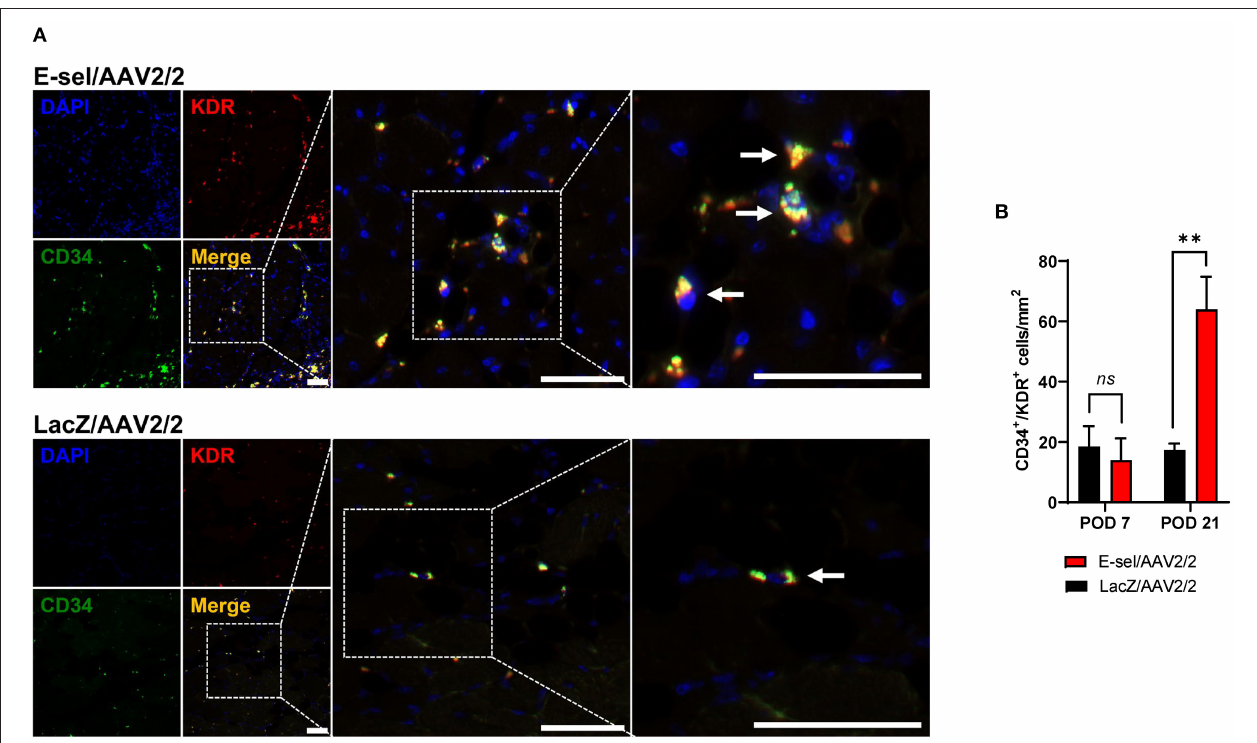
FIGURE 3 | Recruitment of endothelial progenitor cells (EPCs) to ischemic muscle is enhanced by E-sel/AAV2/2. (A) Representative immunofluorescence images demonstrating enhanced colocalization (yellow) of EPC markers CD34 (green) and KDR/VEGFR-2 (red) on POD 21 in muscle treated with E-sel/AAV2/2 compared to LacZ/AAV2/2. EPCs indicated by pointed arrowheads. Scale bars represent 50 µ m. (B) Counting of cells co-staining for CD34 and KDR/VEGFR-2 revealed similar EPC numbers in the acute phase of ischemia (POD 7) but enhanced recruitment of EPCs by POD 21 in muscle treated with E-sel/AAV2/2 compared to LacZ/AAV2/2. Data are presented as mean ± SEM where ** P < 0.01 and ns , not significant ( P >